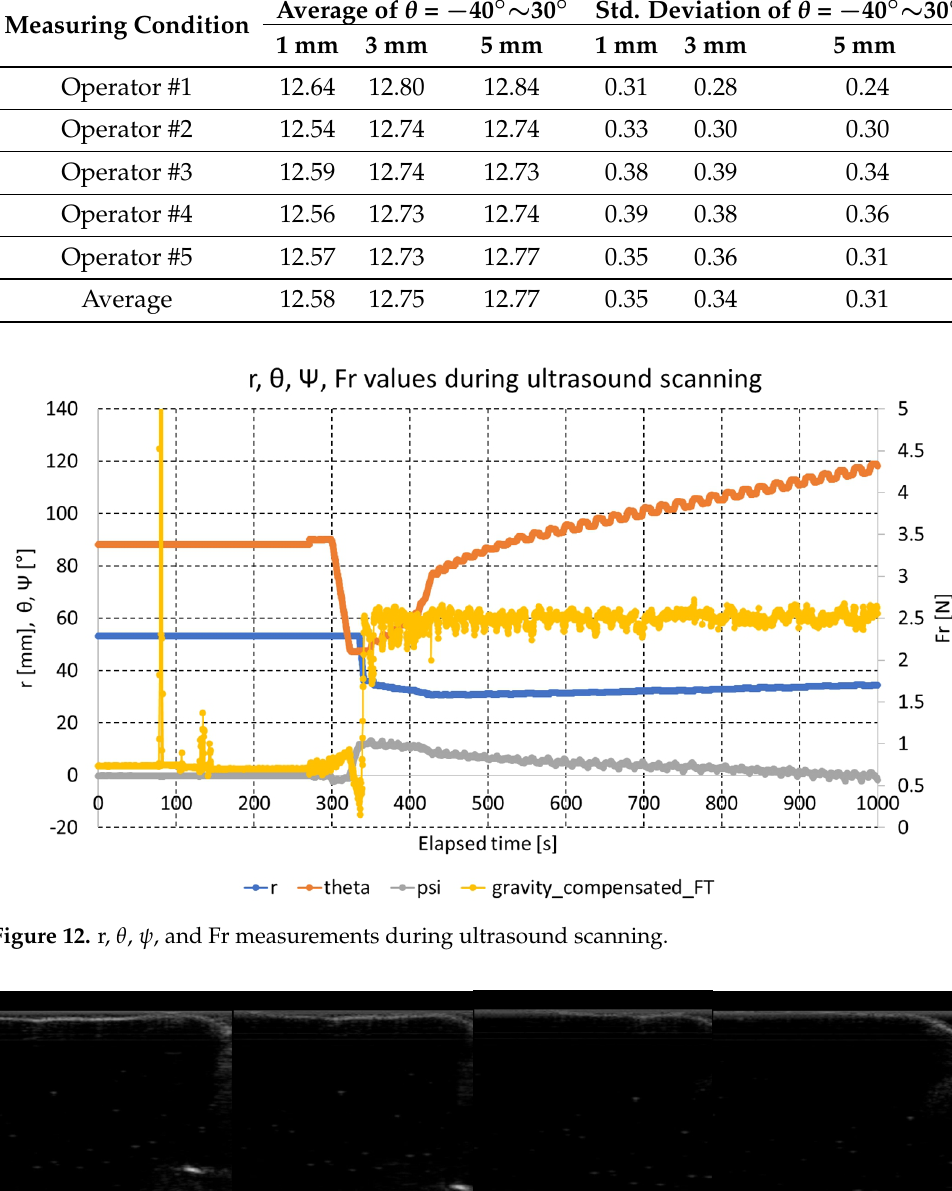
Table 4. Bean curd thickness measurement results (thickness was measured at θ = − 40 ◦ , − 30 ◦ , − 20 ◦ , − 10 ◦ , 0 ◦ , 10 ◦ , 20 ◦ , and 30 ◦ scanning points and averaged). Measuring Condition